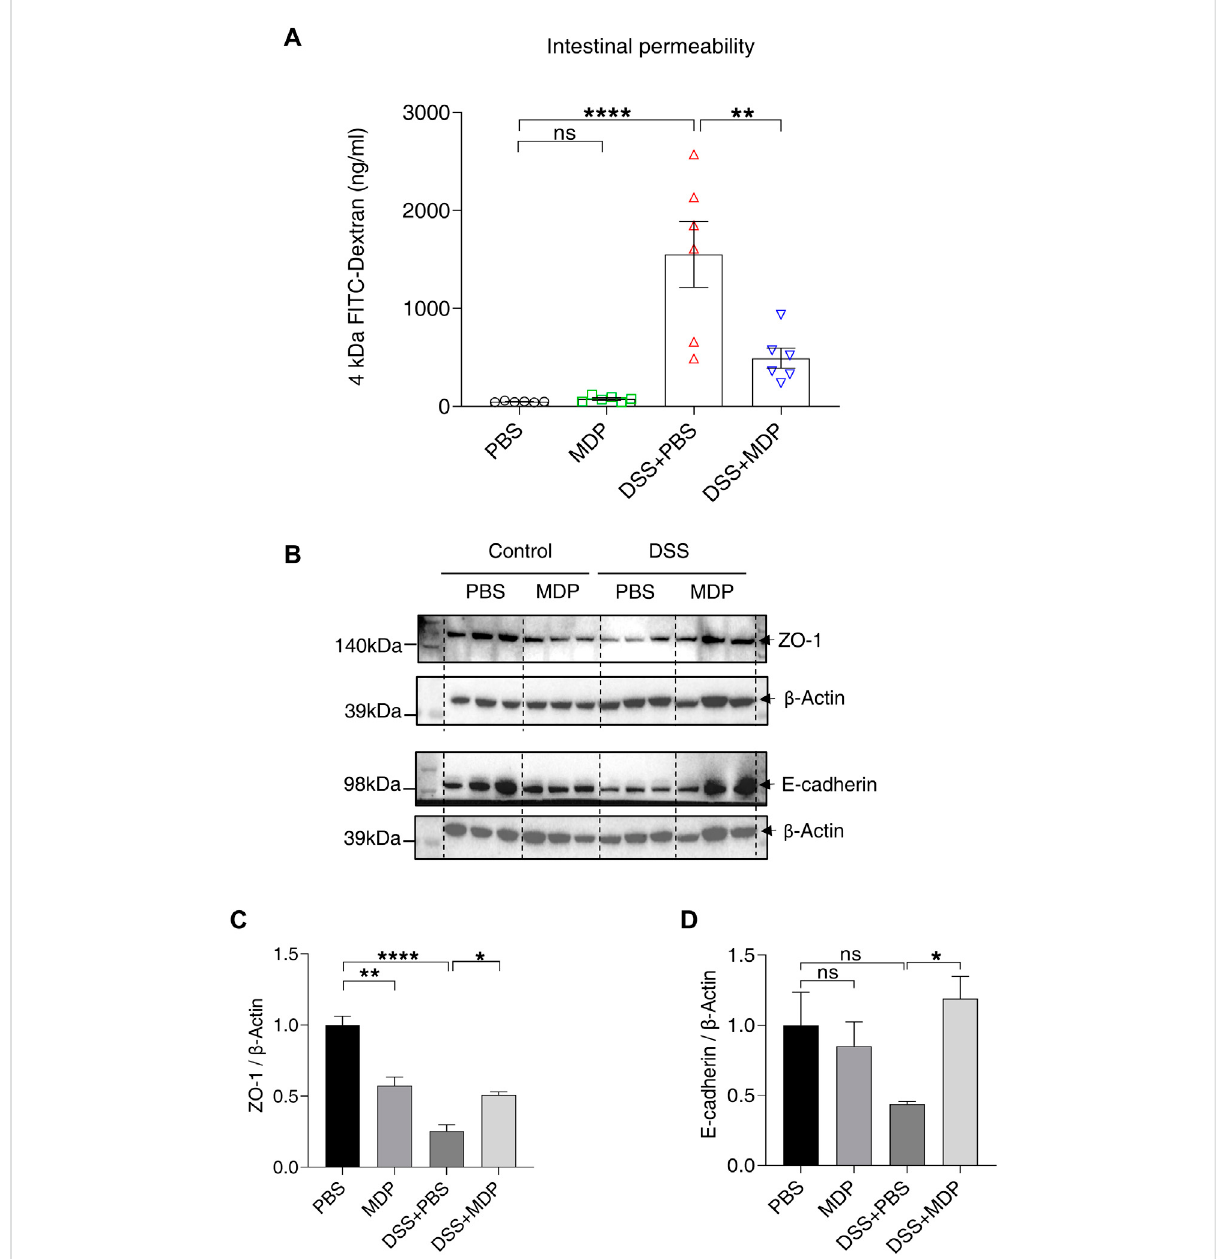
FIGURE 3 MDPreducesDSS-inducedintestinalbarrierdamage. (A) MicewerefastedovernightonDay7andgivenFITC-DextranbygavageonDay8.After 4 h, blood was taken from the eyeball from light. The serum was separated and analyzed for the detection of intestinal permeability (n = 6, each group). (B) Western blotting analysis for ZO-1 and E-cadherin with β -Actin as the internal standard protein in the colon of PBS, MDP, DSS + PBS, and DSS + MDP group mice. Representative images of three duplicate samples of the immune blotting were shown. (C,D) Quanti fi cation of the relative expression of ZO-1 and E-cadherin in panel (B) by ImageJ, respectively. Data were expressed as mean ± SEM. * p < 0.05, ** p <